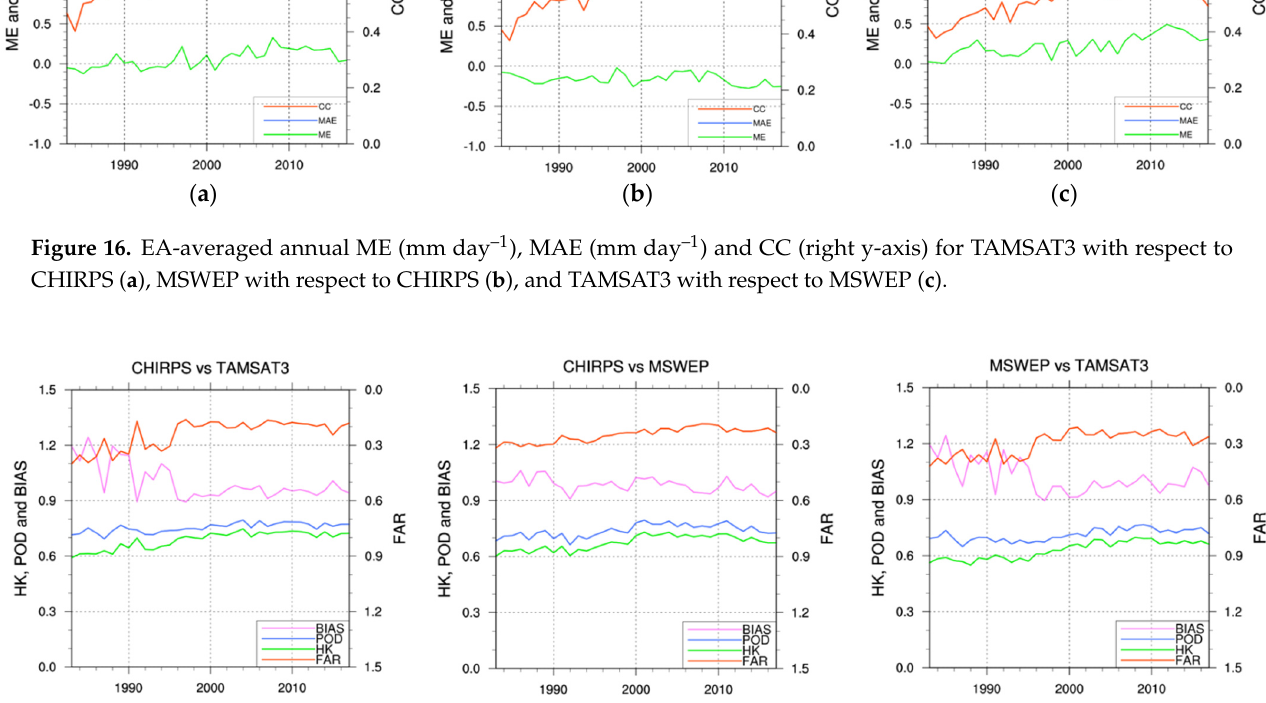
Figure 16. EA-averaged annual ME (mm day –1 ), MAE (mm day –1 ) and CC (right y-axis) for TAMSAT3 with respect to CHIRPS ( a ), MSWEP with respect to CHIRPS ( b ), and TAMSAT3 with respect to MSWEP ( c ).